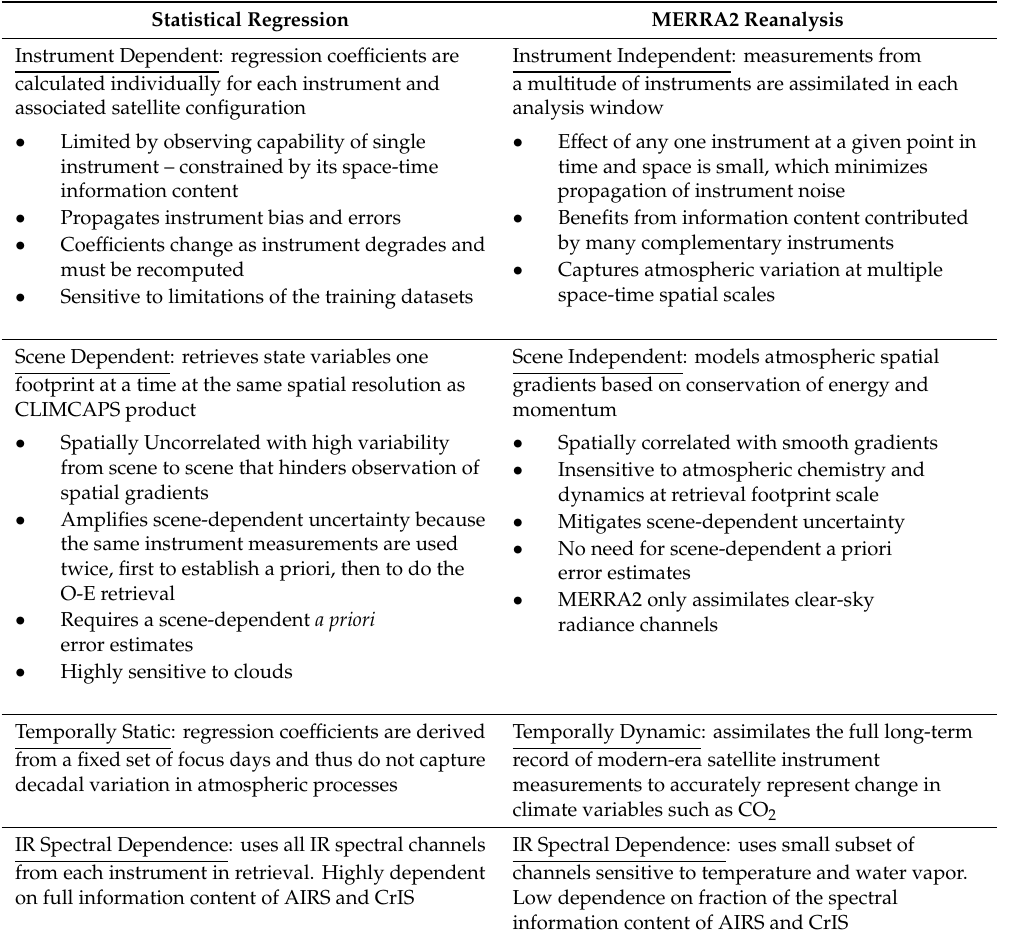
Table 2. Contrasting two datasets in terms of their suitability as Bayesian a priori estimates in CLIMCAPS retrieval of Essential Climate